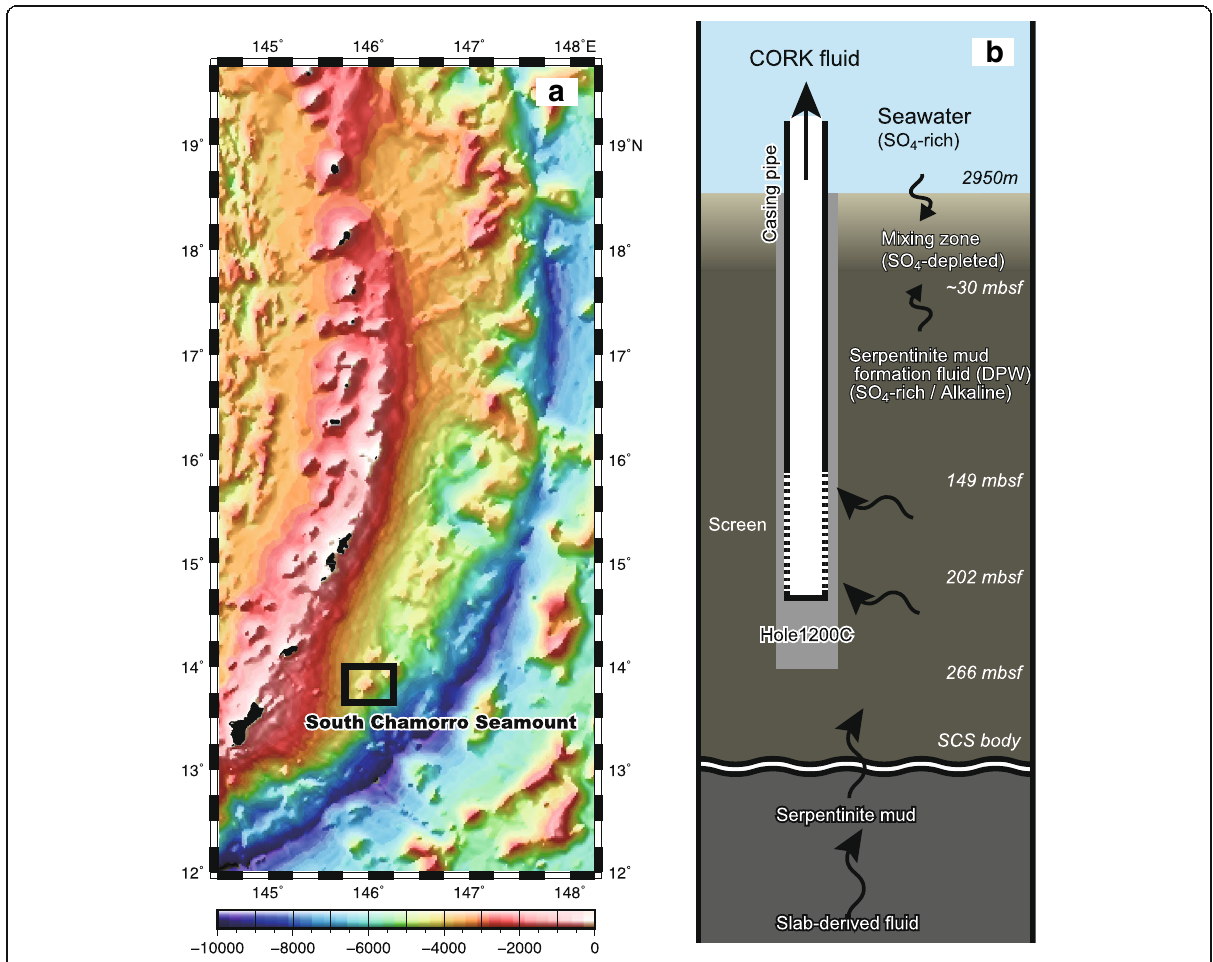
Fig. 1 Topography and schematic illustration of the Mariana forearc and the SCS. a Seafloor topography of the Mariana forearc region. b Schematic illustration of the ODP Hole 1200C focused in the present